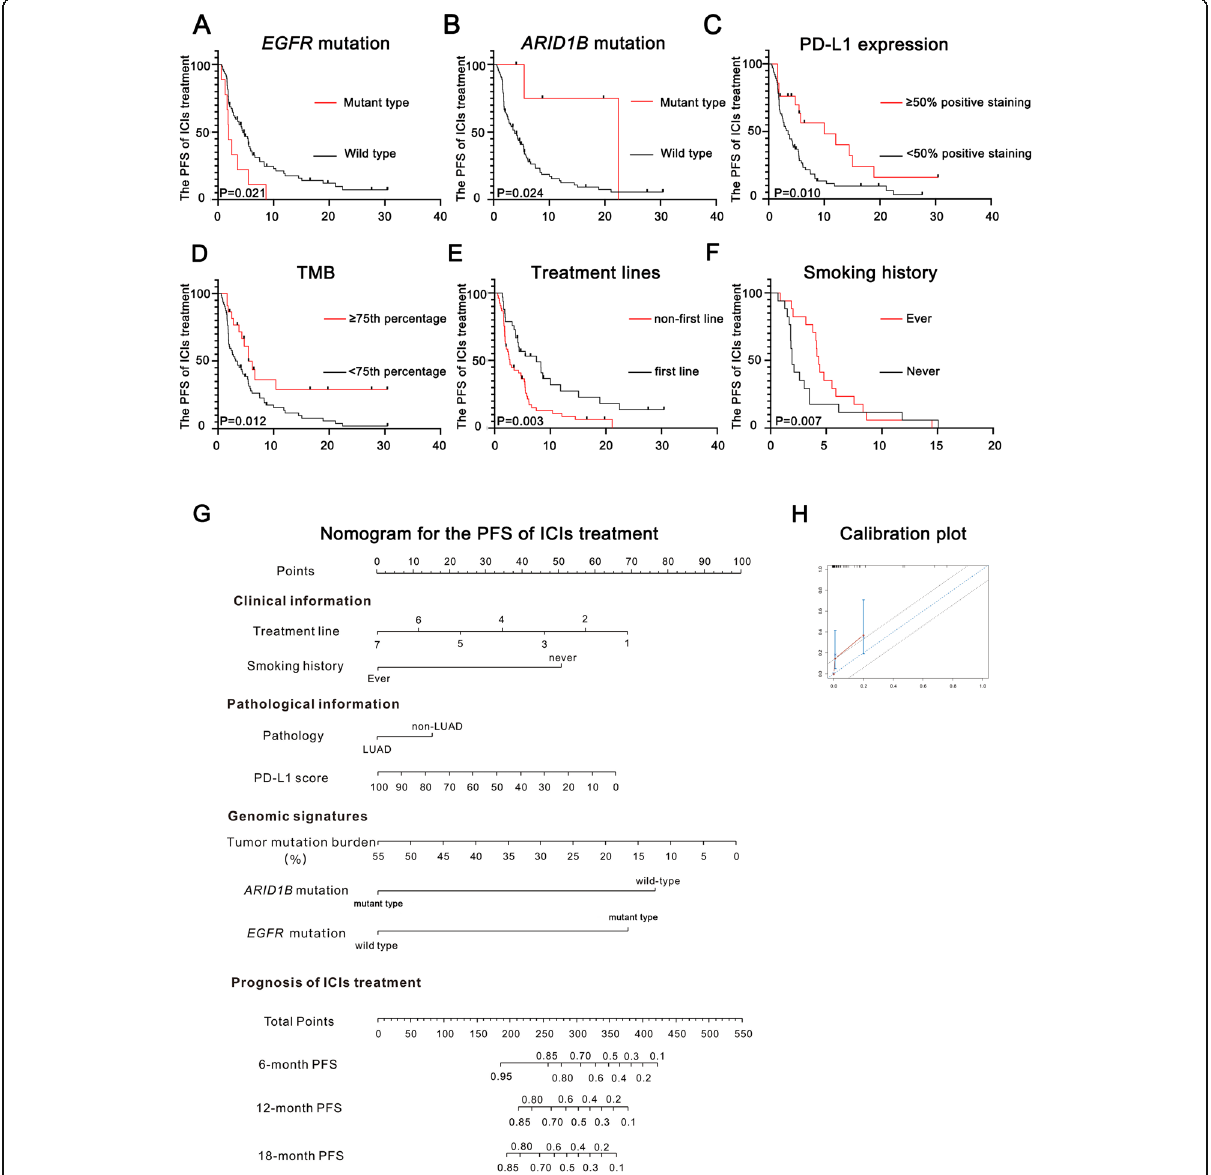
Fig. 3 Novel nomogram to predict the prognosis of immune checkpoint inhibitor (ICI) treatment. a The survival curves for ICIs-treated patients based on the EGFR mutational status; b . The survival curves for ICIs-treated patients based on the ARID1B mutational status; c . The survival curves for ICIs-treated patients based on PD-L1 expression; d . The survival curves for ICIs-treated patients based on the tumor mutational burden (TMB); e . The survival curves for ICIs-treated patients based on treatment lines; f . The survival curves for ICIs-treated patients based on smoking history; g . The novel nomogram based on patient information to predict the prognosis of ICI treatment; h . The calibration plot for the